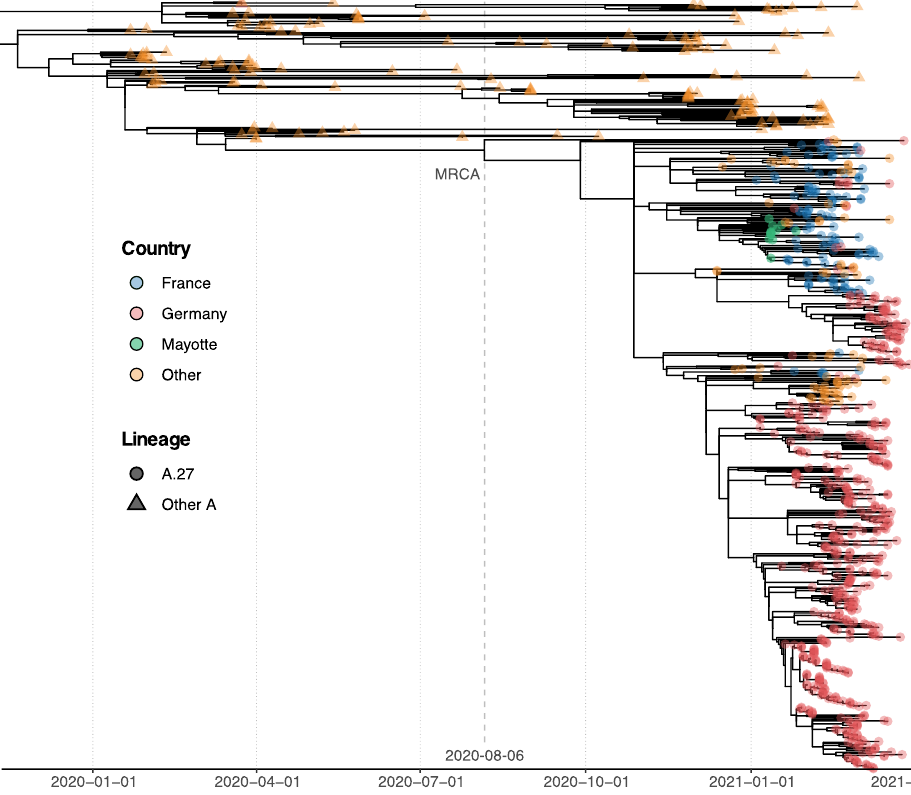
Figure 2. Phylogenetic analysis of A.27 genomes forming a monophyletic group. We also observed three basal A.27 genomes missing some of the seven characteristic A.27 spike mutations and showing no deletions in spike. The most recent common ancestor (MRCA) was dated to 8 August